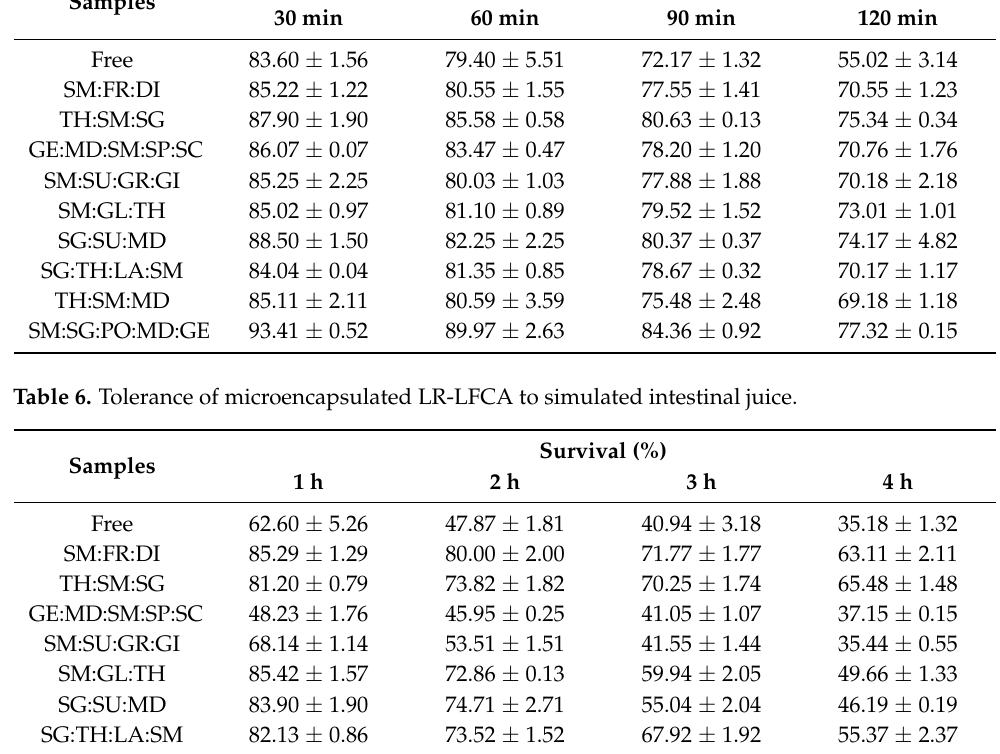
Table 5. Tolerance of microencapsulated LR-LFCA to simulated gastric juice. Samples